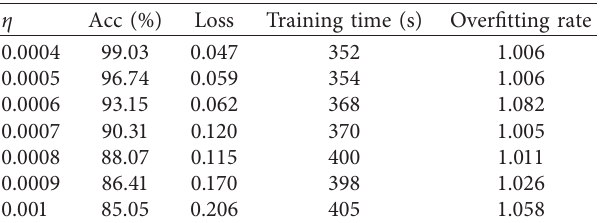
Table 2: Effects of different learning rates on the training effect of deep reconstruction network